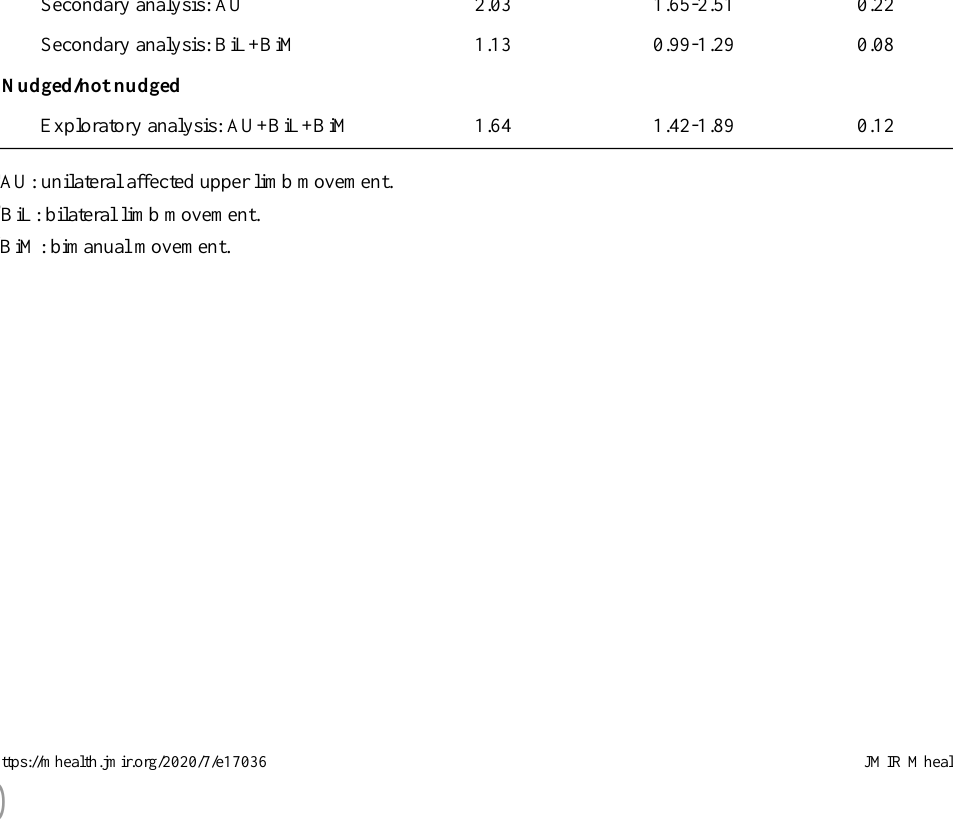
Table 2. Odds of an affected upper limb (UL) movement recorded during the observation periods. Planned nudge/no nudge <.0015.860.091.28-1.631.44Primary analysis: AU a +BiL b +BiM